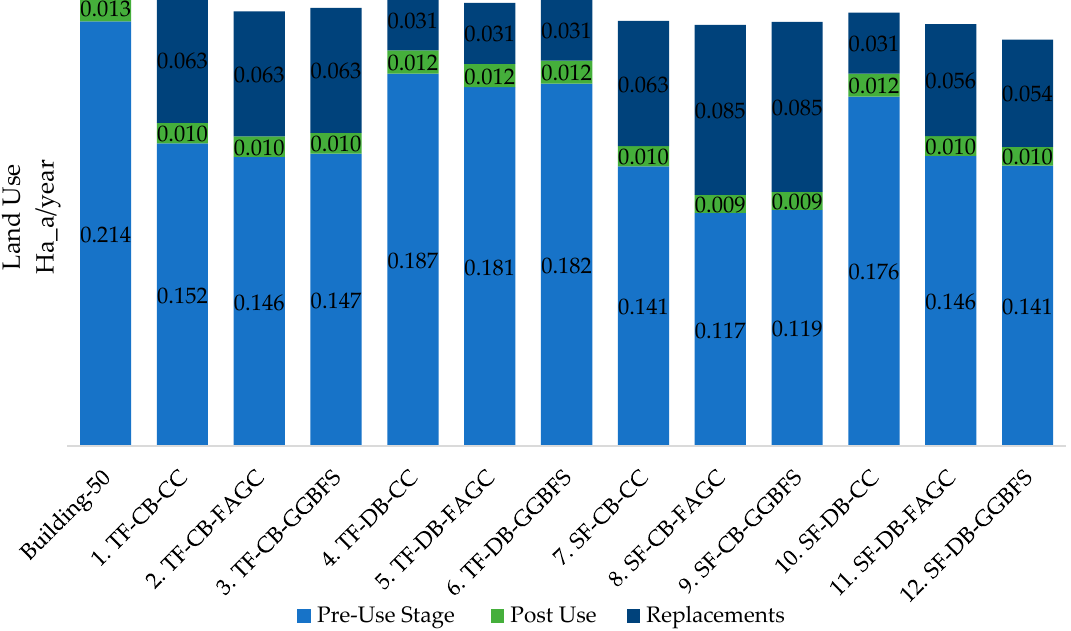
Figure 5. Life cycle land use per year per building for 12 buildings and Building-50. (Use stage is omitted in the graph as the use-stage Land use value 1.353 Ha_a/year is uniform in all cases and if plotted on same scale, other stages due to low values cannot be presented properly).